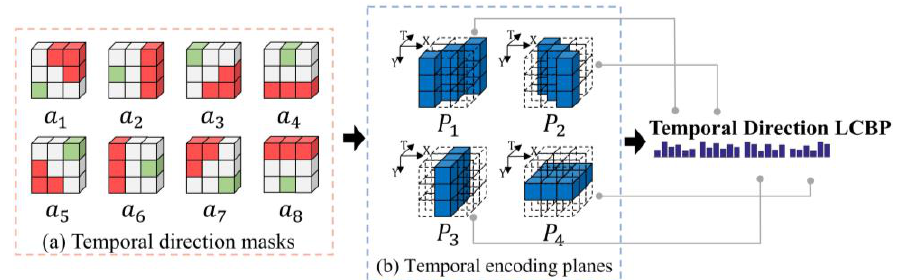
Figure 5. The encoding process of Temporal Direction LCBP. ( a ) The diagram of eight direction masks in the sampling plane. ( b ) The sampling range of the temporal planes in the cube